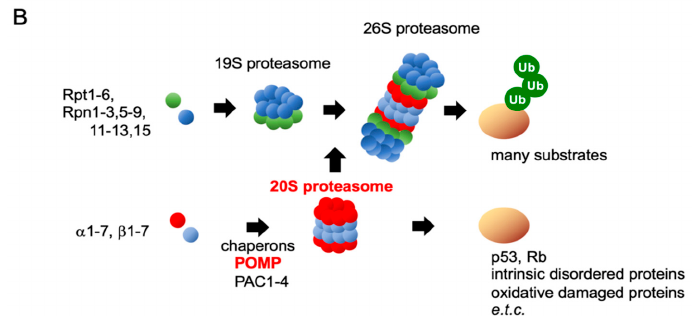
Figure 3. Three biological functions of NRF3 in cancer. ( A ) NRF3 exhibits three biological functions by regulating gene expression in colon cancer. (Top) In colorectal cancer cells, NRF3, the expression of which is induced by the β -catenin/T-cell transcription factor 4 (TCF4) complex, enhances the assembly of the 20S proteasome by inducing the proteasome maturation protein (POMP) chaperone gene. Consequently, the 20S proteasome degrades the tumor suppressors p53 and retinoblastoma (Rb) in a ubiquitin-independent manner, preventing cell cycle arrest and apoptosis. (Middle) NRF3 is also induced by the NF-kB complex, including RELA in colon cancer cells, and activates cell proliferation by repressing the CDK inhibitor DUX4 gene and consequently activating CDK1 [22]. (Bottom) NRF3 represses the translation of NRF1 by inducing cytoplasmic polyadenylation element-binding protein 3 (CPEB3) and modulates basal proteasome activity in colon cancer cells [27]. ( B ) Schematic representation of the molecular mechanisms of proteasome assembly. The 26S proteasome comprises 20S and 19S proteasomes containing 66 subunits [28–30]. The assembly of each proteasome complex is tightly regulated in a coordinated manner by distinct chaperones. The 20S proteasome is assembled by proteasome assembling chaperone 1–4 (PAC1–PAC4) and POMP